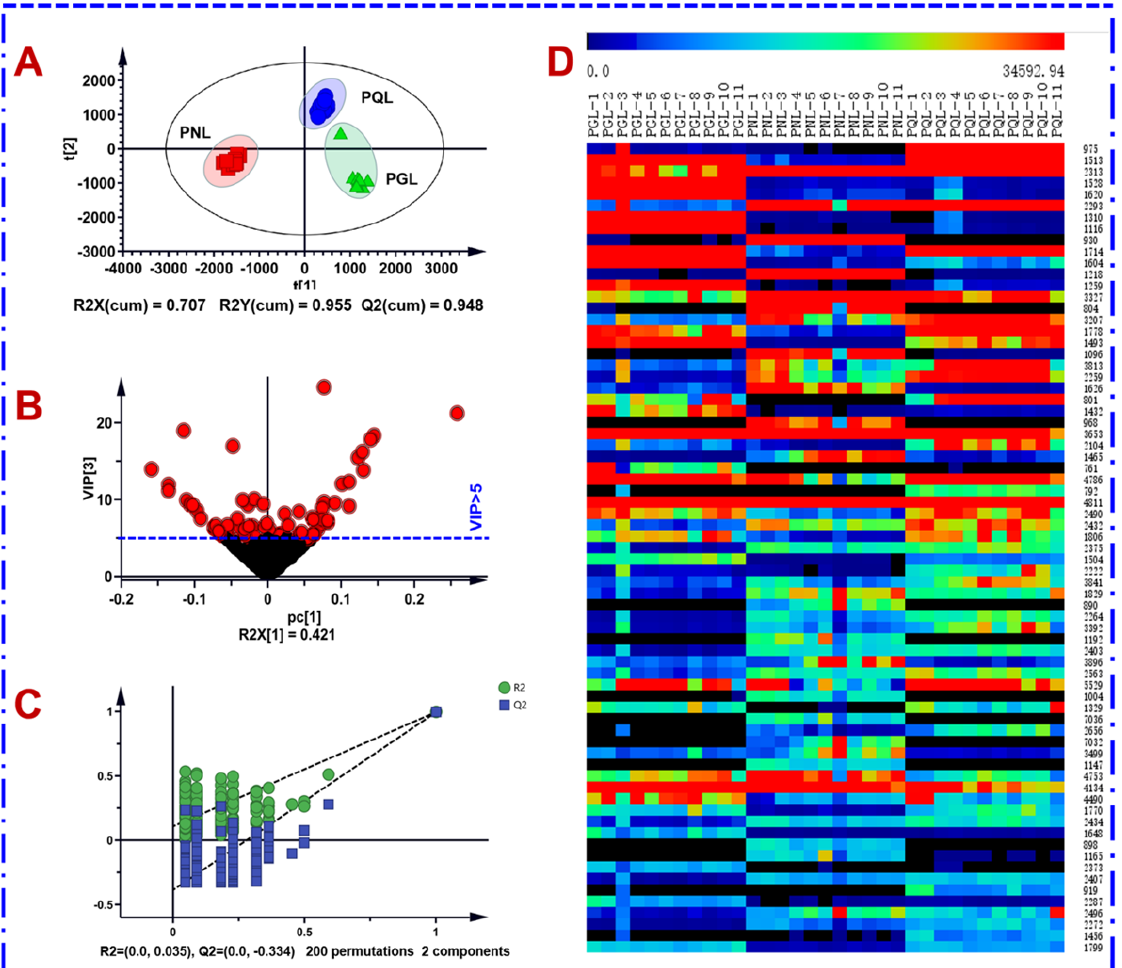
Figure 7. Multi-variate statistical analysis of 33 batches of the leaf samples of three Panax species (PGL/PQL/PNL) using OPLS-DA based on the negative-mode MS E data. ( A ): Score plot; ( B ): VIP plot; ( C ): permutation test; ( D ): heat map of 72 differential ions among the tested leaf samples.